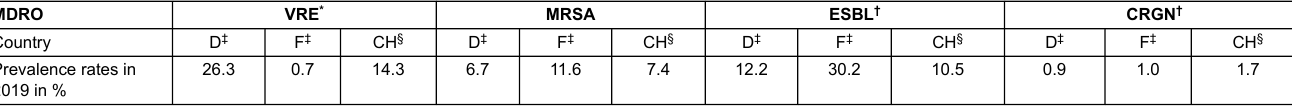
Table 1: Prevalence rates of multidrug-resistant organisms in France, Germany and Switzerland in 2019. MDRO VRE * MRSA ESBL † CRGN †